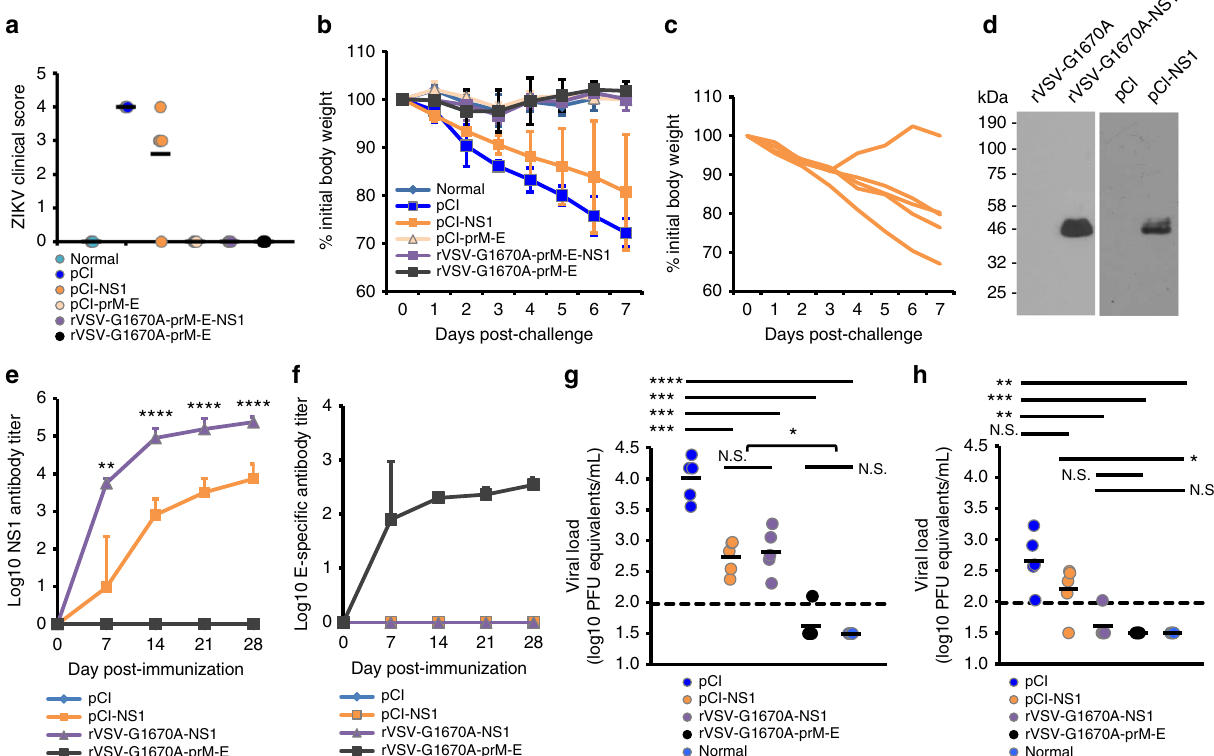
Fig. 6 NS1 alone provides partial protection against ZIKV challenge. a – c Experiment in A129 mice. A129 mice were immunized with a single dose (10 5 PFU) of mtdVSV-based vaccine or two doses (50 µ g each, two weeks apart) of DNA vaccine. At week 4 post-immunization, mice were intraperitoneally challenged with 10 5 PFU of ZIKV Cambodian strain. a Clinical score in A129 mice after ZIKV challenge. ZIKV-associated clinical signs were scored for each mouse. 1 = healthy; 2 = mild: ruf fl ed fur but no neurological symptoms; 3 = moderate: ruf fl ed fur, hindlimb weakness, and partial hindlimb paralysis; and 4 = severe: paralysis, moribund and early removal is required. b Body weight change in A129 mice after ZIKV challenge. After ZIKV challenge, body weight for each mouse was evaluated daily. The average body weights of fi ve mice ± standard deviation were shown. c Body weight change of A129 mice in pCI-NS1 group after ZIKV challenge. Each line represents individual animal. One mouse had 10% of body weight loss and was recovered after ZIKV challenge. d Expression of ZIKV NS1 protein by rVSV-G1670A and pCI vectors. BSRT7 cells were infected by rVSV-G1670A-NS1 at an MOI of 3.0 or transfected with 4 µ g of pCI-NS1, and cell lysates were harvested at day 3, and subjected to western blotting using ZIKV NS1 antibody. e - h Experiment in BALB/c mice. 4-week-old BLAB/c mice were immunized with two doses (50 µ g each, two weeks apart) of pCI-NS1, or a single dose (10 6 PFU) of mtdVSV- NS1 or mtdVSV-prM-E. At week 4 post-immunization, mice were administered 1.8 mg of anti-IFNAR1 blocking antibody and challenged intravenously with 10 6 PFU of ZIKV Cambodian strain. e NS1-speci fi c antibody response in BALB/c mice. P value (by Student ’ s t -test) from top to bottom: **** P = 3.95 × 10 − 5 , **** P = 3.48 × 10 − 5 , **** P = 1.51 × 10 − 5 , ** P = 0.00183. Data shown are the GMT of 5 mice ± standard deviation. f E-speci fi c antibody responses in BALB/c mice. Data shown are the GMT of 5 mice ± standard deviation. g NS1 alone provided partial protection against viremia in BALB/c mice at day 3 post- challenge. The level of viremia was measured by real-time RT-PCR at day 3 post-challenge. P value (by Student ’ s t -test) from top to bottom: **** P = 4.15 × 10 − 6 , *** P = 0.000161, *** P = 0.000767, *** P = 0.000187, * P = 0.0250. h NS1 alone provided protection against viremia in BALB/c mice at day 7 post- challenge. P value (by Student ’ s t -test) from top to bottom: ** P = 0.00510, *** P = 0.000114, ** P = 0.00277, * P = 0.0308. Data shown are the mean of 5 mice. N.S., not signi fi cant Brie fl y, BALB/c mice were immunized intramuscularly with two had a signi fi cant level of viremia ( P < 0.001, t -test) (Fig. 6h). These doses (50 µg each) of pCI-NS1 or intranasally with one dose (10 6 results showed that NS1 alone was capable of triggering signi fi cant PFU) of rVSV-G1670A-NS1 or rVSV-G1670A-prM-E, and were protection against ZIKV-induced viremia and that rVSV-G1670A- challenged intravenously with 10 6 PFU of ZIKV at week 4 post- immunization. We found that rVSV-G1670A-NS1 triggered signi fi cantly higher NS1-speci fi c antibody than pCI-NS1 in mice (Fig. 6e). As a positive control, recombinant rVSV-G1670A-prM-E triggered a high level of E-speci fi c antibody (Fig. 6f). At days 3 post- NS1 . Finally, we further validated the protection ef fi cacy of rVSV- challenge, mice in rVSV-G1670A-NS1 and pCI-NS1 groups had a similar level of viremia ( P > 0.05, t -test) but were signi fi cantly lower and viremia for a prolonged time (until day 21 after challenge than pCI control ( P < 0.05, t -test) (Fig. 6g). As a positive control, the with ZIKV). As shown in Fig. 8a, there were no signi fi cant viremia level in the rVSV-G1670A-prM-E group was below or near differences in body weight gain among three groups ( P > 0.05, t - detection limit (Fig. 6g). At day 7 post-challenge, mice in the rVSV- G1670A-NS1 and rVSV-G1670A-prM-E groups had no detectable viremia (except one in rVSV-G1670A-NS1 group which was near the detection limit) whereas mice in pCI and pCI-NS1 groups still NATURE COMMUNICATIONS| (2018) 9:3067 |DOI: